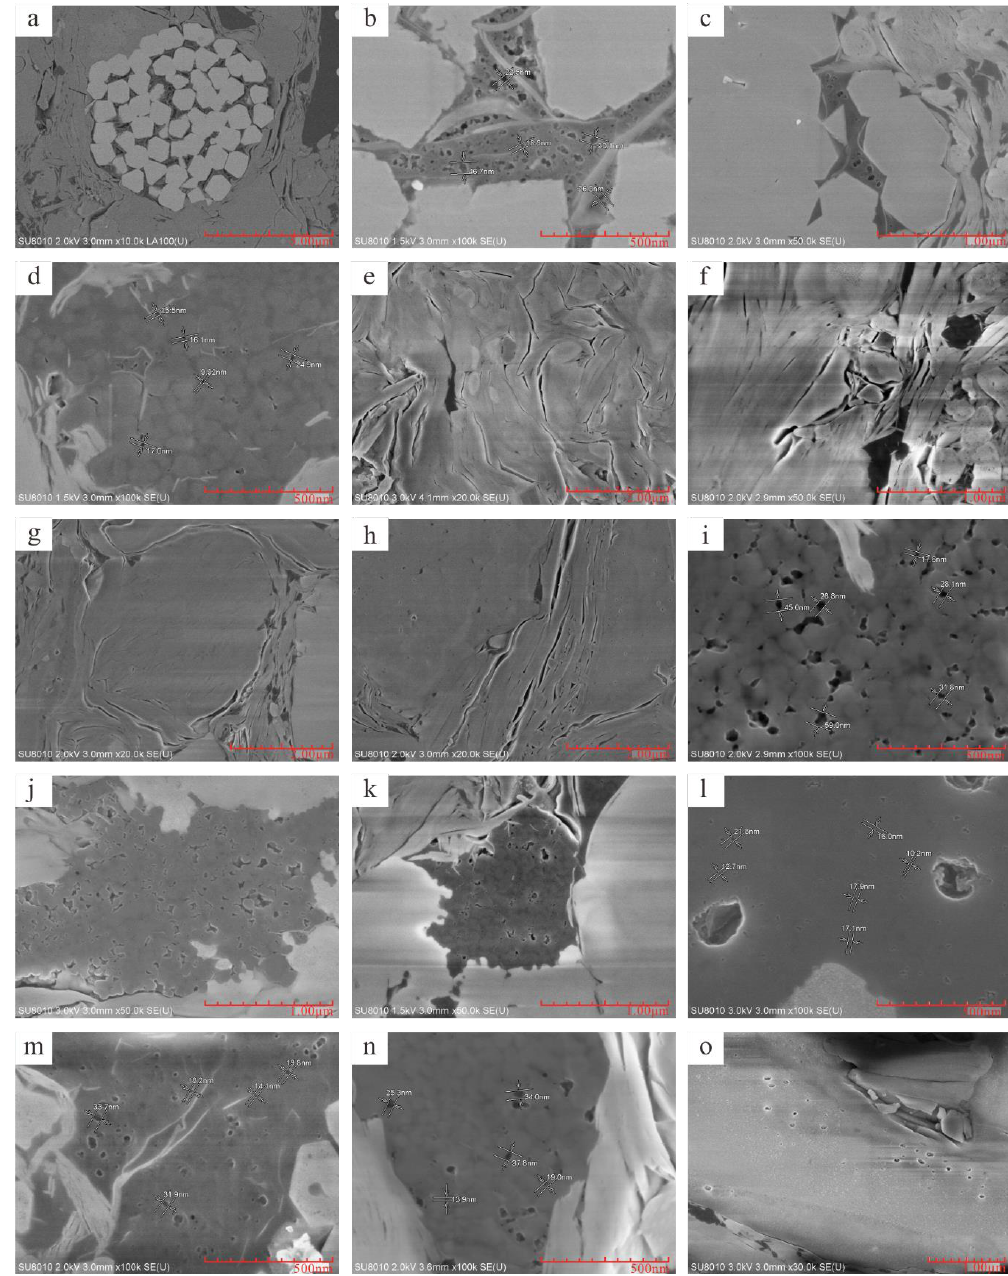
Figure 8. Combined broad ion beam-milling and scanning electron microscopy (BIB-SEM) images